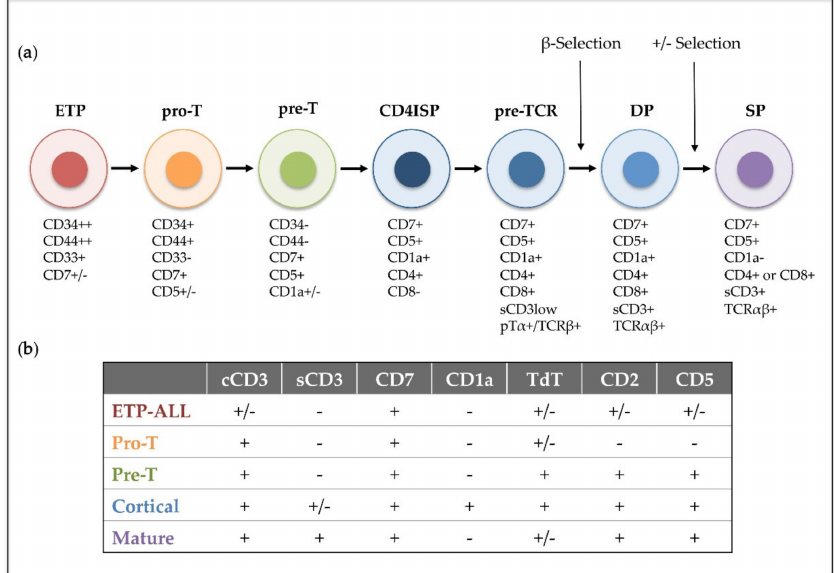
Figure 1. Human intrathymic T-cell developmental stages and corresponding T-ALL phenotypic subtypes. ( a ) Early thymic precursors (ETP) that have entered the human thymus di ff erentiate through sequential developmental stages: pro-T, pre-T, immature CD4 single positive (CD4ISP), pre-T-cell receptor (pre-TCR), double positive CD4 + CD8 + (DP) and single posive (SP), which can be identified by the expression of di ff erent cell surface markers and the sequential acquisition of the pre-TCR and the TCR αβ receptors. ( b )T-ALLsubtypes(ETP-ALL,Pro-T,Pre-T,CorticalandMature)arebasedonthe1995 EGIL classification of acute leukemias and the 2017 WHO classification of Tumours of Haematopoietic and Lymphoid Tissues, which included ETP-ALL as a new provisional entity. This classification was established by immunophenotyping based on surface molecules expressed at sequential intrathymic stages of human T-cell development. cCD3 (cytoplasmic CD3); sCD3 (surface CD3); TdT (terminal deoxynucleotidyl transferase). Presence or absence of the indicated molecule is represented by ( + ) and ( − ),